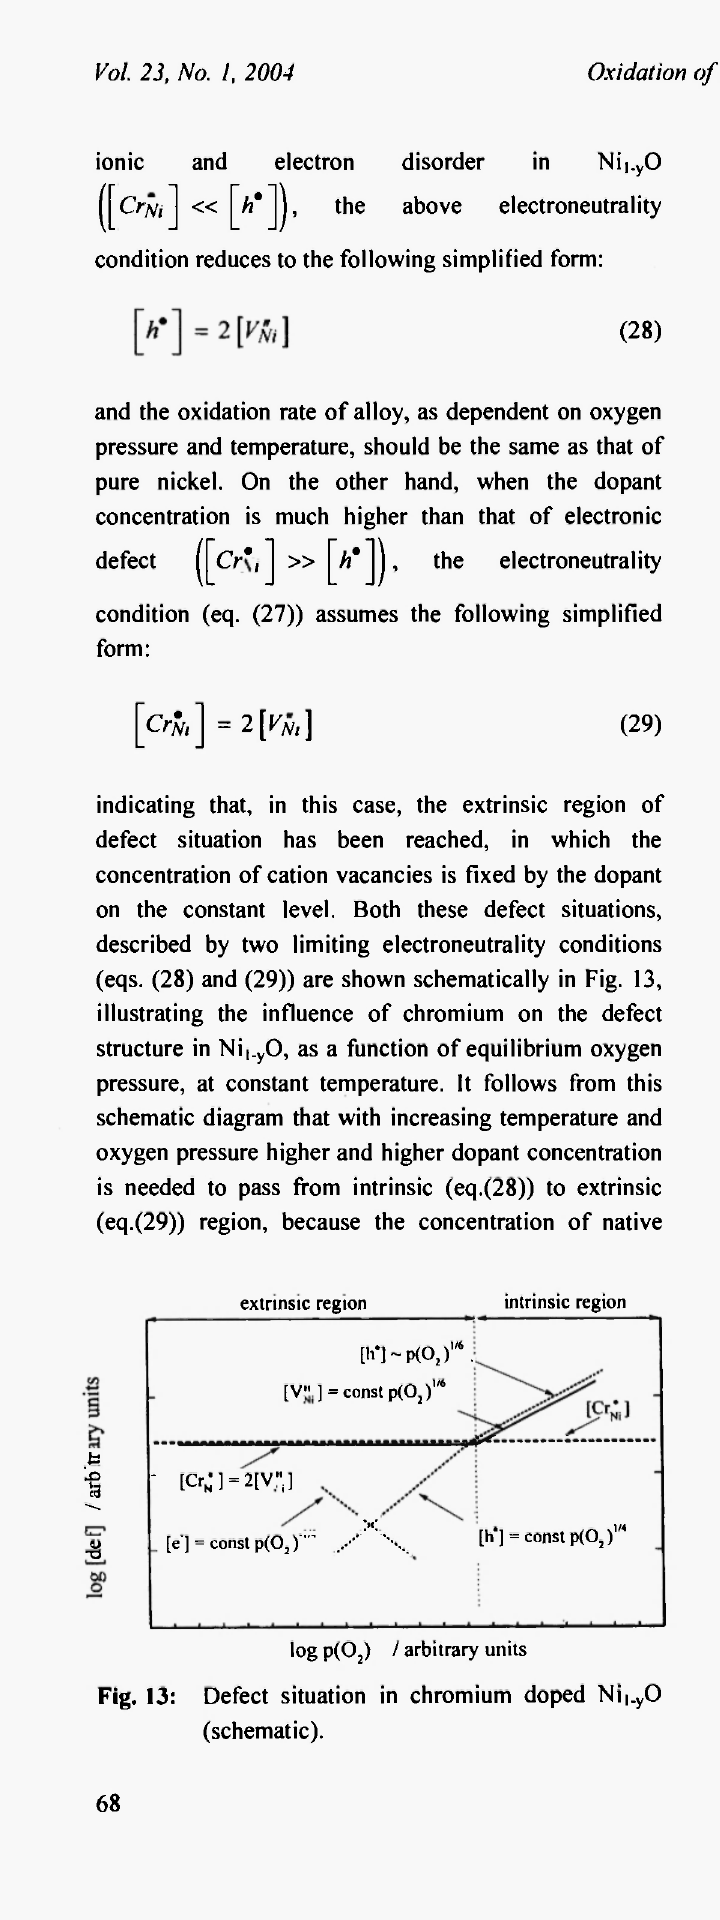
Fig. 13: Defect situation in chromium doped Ni|. y O